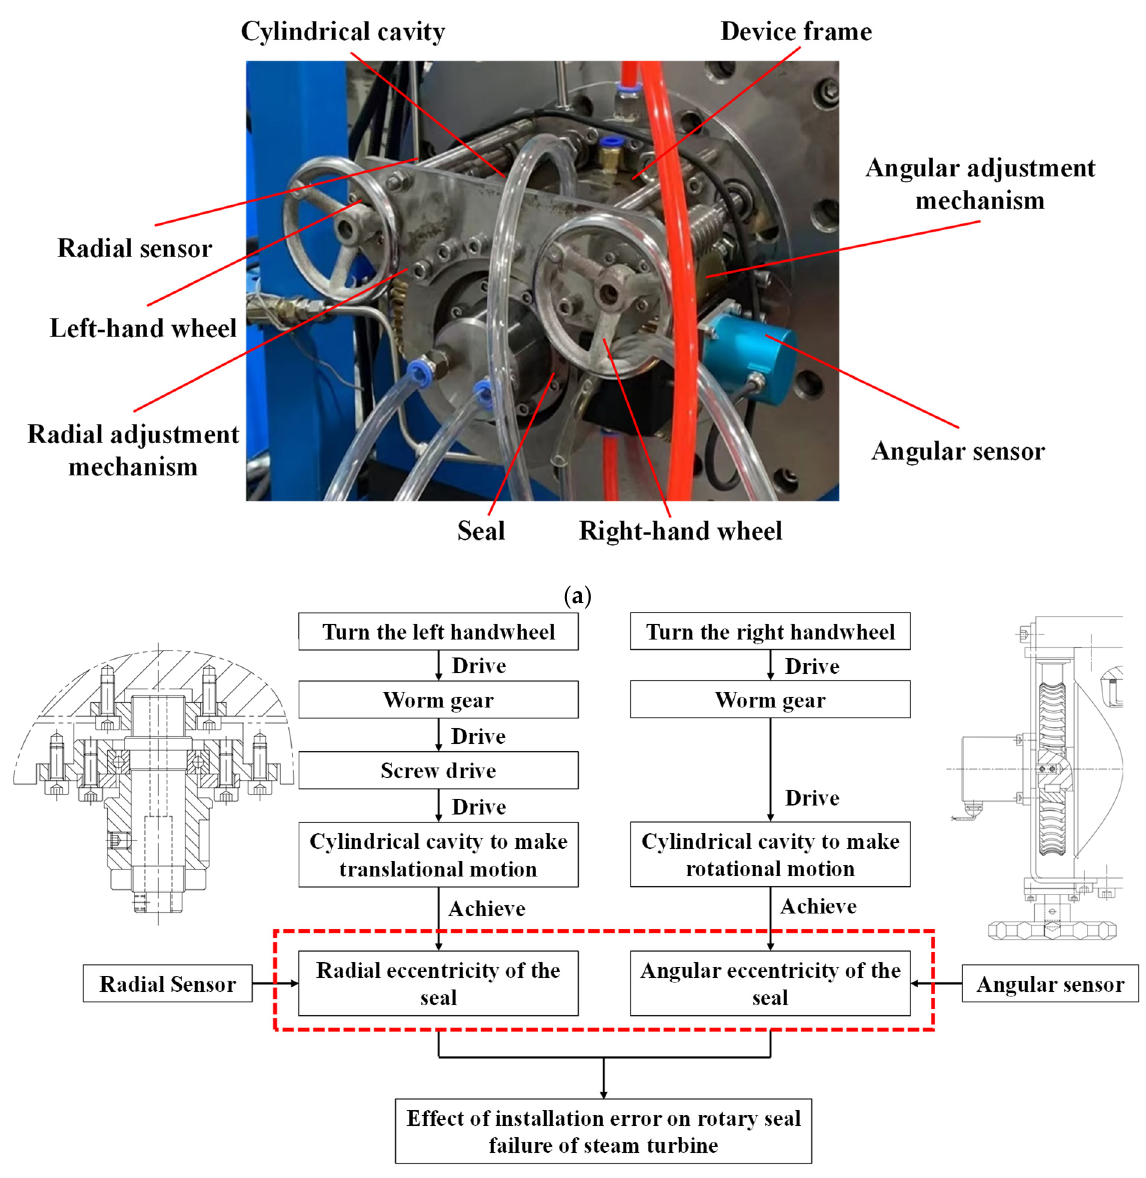
Figure 13. Adjustment device with precise adjustment, self-locking, and electronic measurement. ( a ) Adjustment device; ( b ) principle of adjustment device.